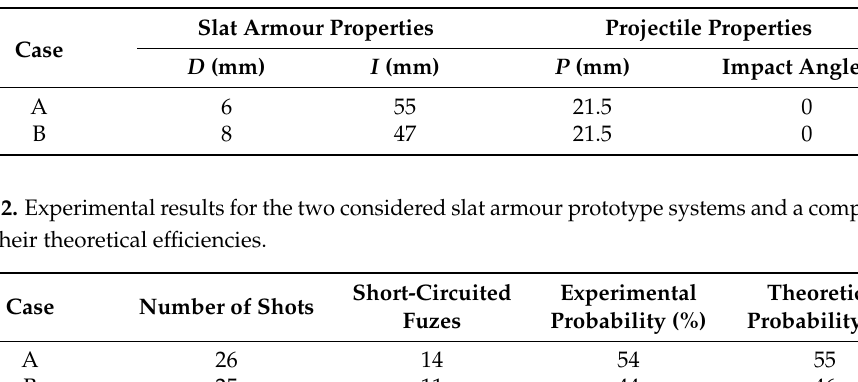
Table 1. Relevant slat armour and projectile properties.